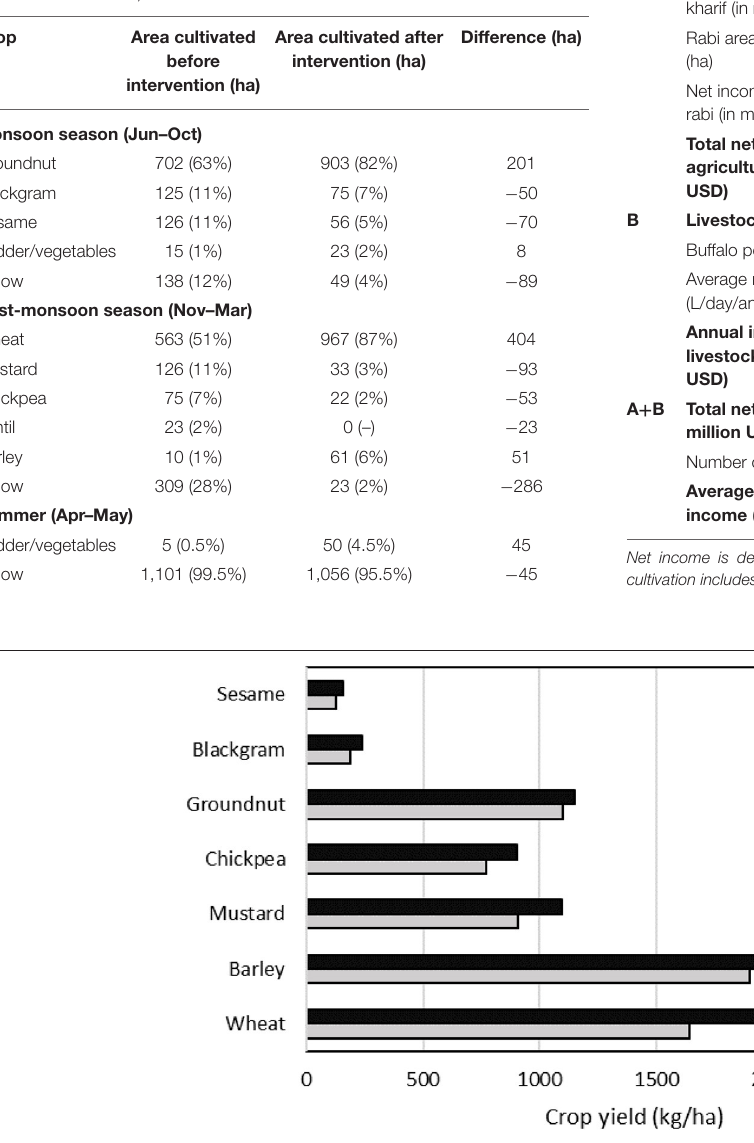
TABLE 2 | Cultivated area under different crops before and after project interventions in Parasai-Sindh watershed (figures in parenthesis indicate percent of total cultivable land).